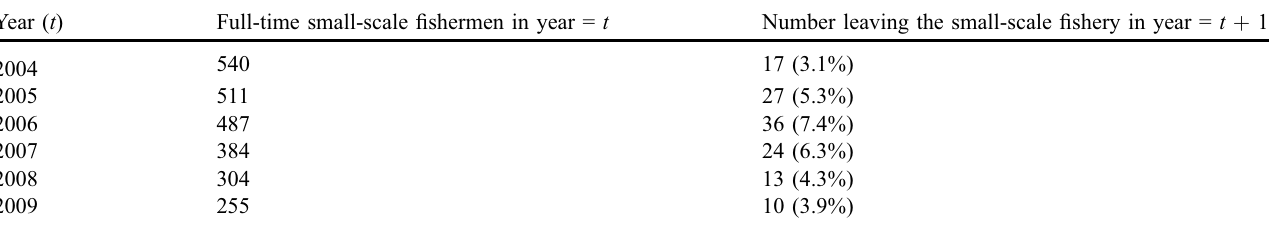
Table 2. Number of full-time small-scale fi shermen in each of the years ( t ) 2004 – 2009 and the number leaving the fi shery in year t þ 1 in each